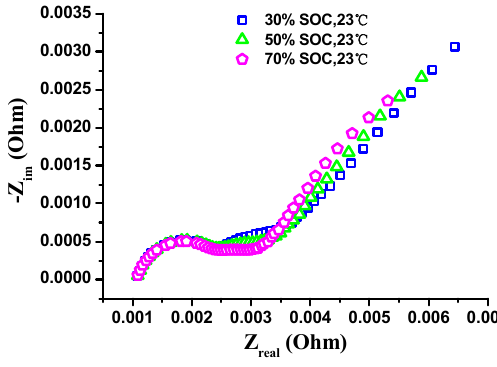
Figure 13. Electrochemical impedance spectrum (EIS) curves at different state of charges (SOCs) when the test temperature is 0 °C.